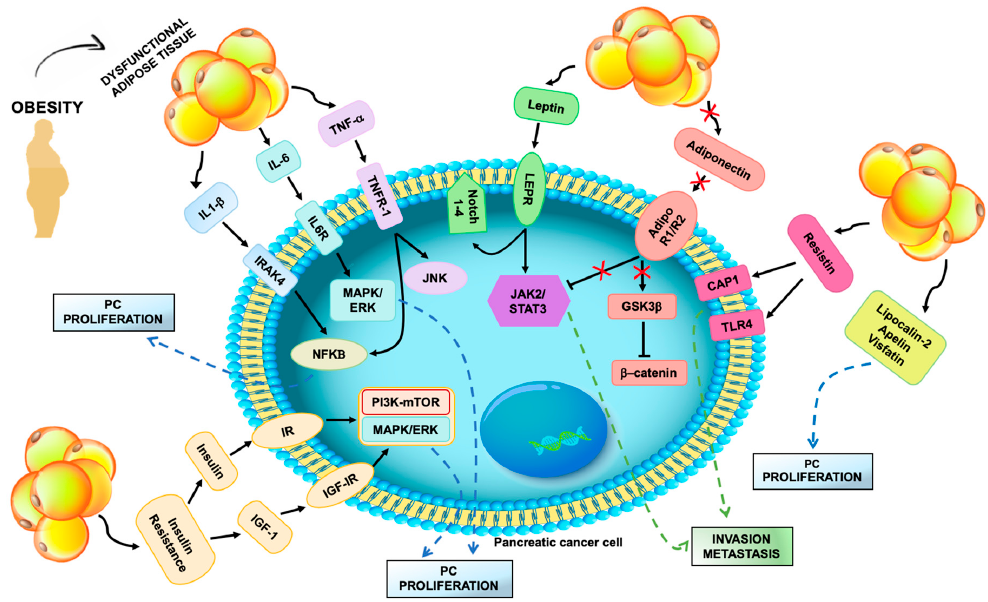
Figure 1. Systemic mediators of dysfunctional adipose tissue effects on pancreatic cancer cell. Excess fat accumulation induces hypoxia and low-grade inflammation in the adipose tissue, resulting in altered secretion of pro-inflammatory cytokines and adipokines. Increased release of TNF- α , Interleukin-1 β (IL-1 β ) and IL-6 stimulate pancreatic cancer (PC) cell proliferation via activation of the NF-kB, MAPK/ERK and JNK signaling pathways. Elevated circulating leptin may drive pancreatic tumor invasion and metastasis triggering the JAK2/STAT3 axis. Other adipokines, including resistin, lipocalin-2, apelin and visfatin, may also promote PC growth and progression. Reduced release of adiponectin by dysfunctional adipocytes decreases tumor-suppressor effects of adiponectin, mediated by JAK2/STAT3 inhibition and down-regulation of intracellular β -catenin. Expansion and inflammation of visceral adipose tissue induce insulin resistance that fosters systemic secretion of insulin and IGF-1. Activation of insulin receptor (IR) and insulin-like growth factor-I receptor (IGF-IR) enhances PC proliferation through the PI3K/mTOR and MAPK/ERK pathways. Table 1. Summary of main in vitro and in vivo studies investigating the link between dysfunctional adipose tissue and pancreatic cancer.